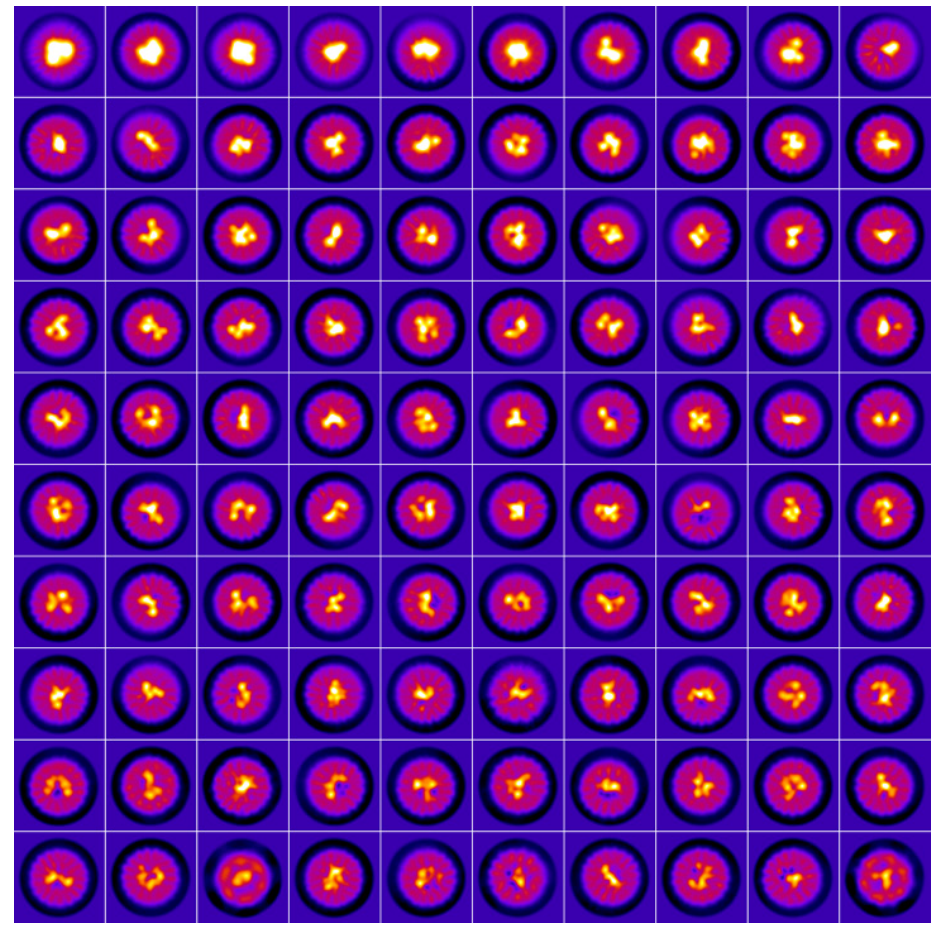
Figure 4. Cryo-EM class averages demonstrating various morphologies of the iron cluster inside the Dps. Merged dataset from all the samples under study. Dps dodecamers with empty cavities as well as with the smallest (~1 nm 3 ) iron clusters are excluded.